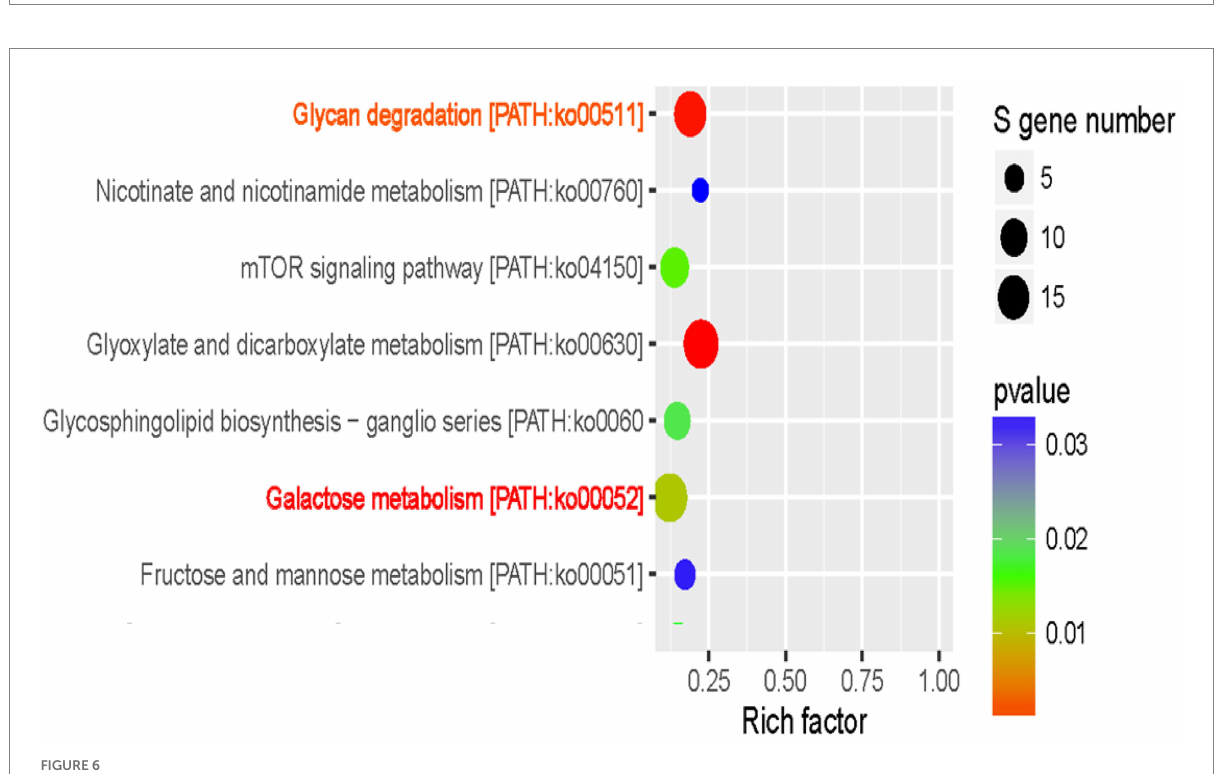
FIGURE 6 Kyoto Encyclopedia of Genes and Genomes enrichment analysis of